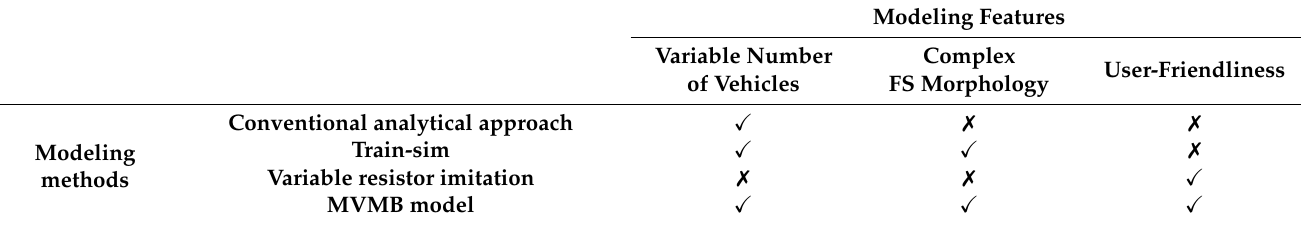
Table 7. Comparison of the catenary modeling